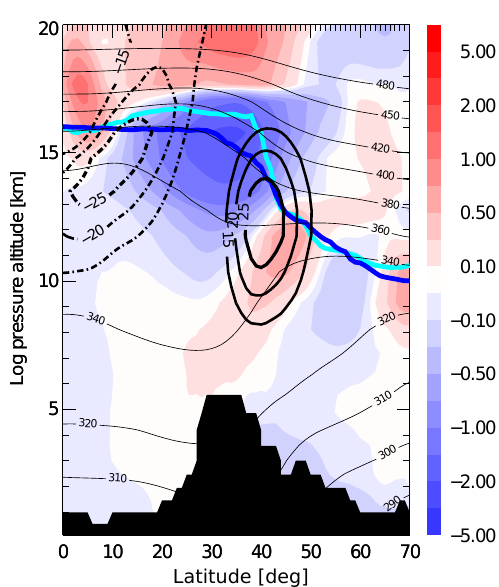
Figure 1. Meteorological conditions in the Asian monsoon anticy- clone (based on ERA–Interim reanalysis). Color shading shows the PV anomaly of the monsoon longitude section (60–120 ◦ E) with re- spect to the zonal mean, averaged over summer (June-August). Also shown is zonal wind (thick black, solid/dashed positive/negative) and potential temperature (thin black) averaged between 60–120 ◦ E. The first thermal tropopause (calculated using the definition of WMO, 1957) zonally averaged over 0–360 ◦ E is shown as dark- blue, averaged over 60–120 ◦ E as cyan